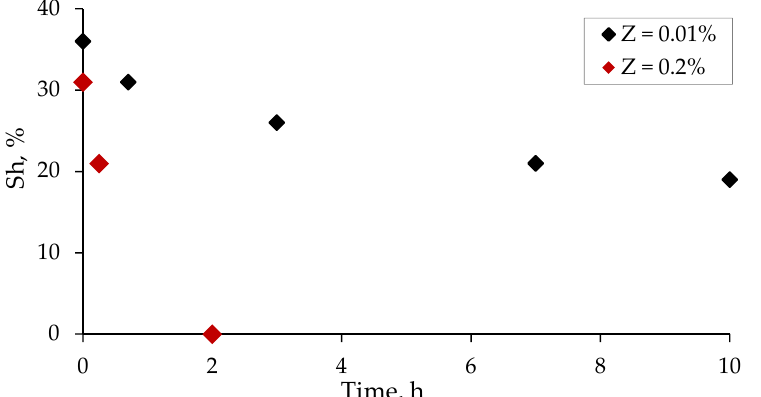
Figure 10. Time-dependent hydrate saturation in saline (Z = 0.2%) and nonsaline (Z = 0.01%) sand samples (W = 10%) after the pressure dropped to 0.1 MPa at −6 ℃ .